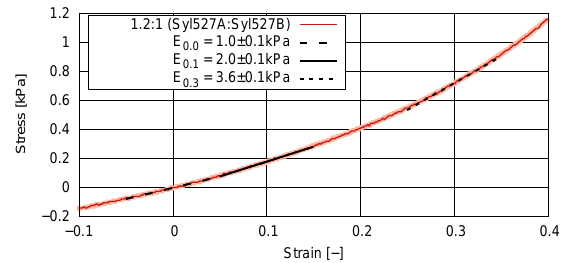
Figure 7. Deformation behaviour of 1.2 to 1.0 (Syl-